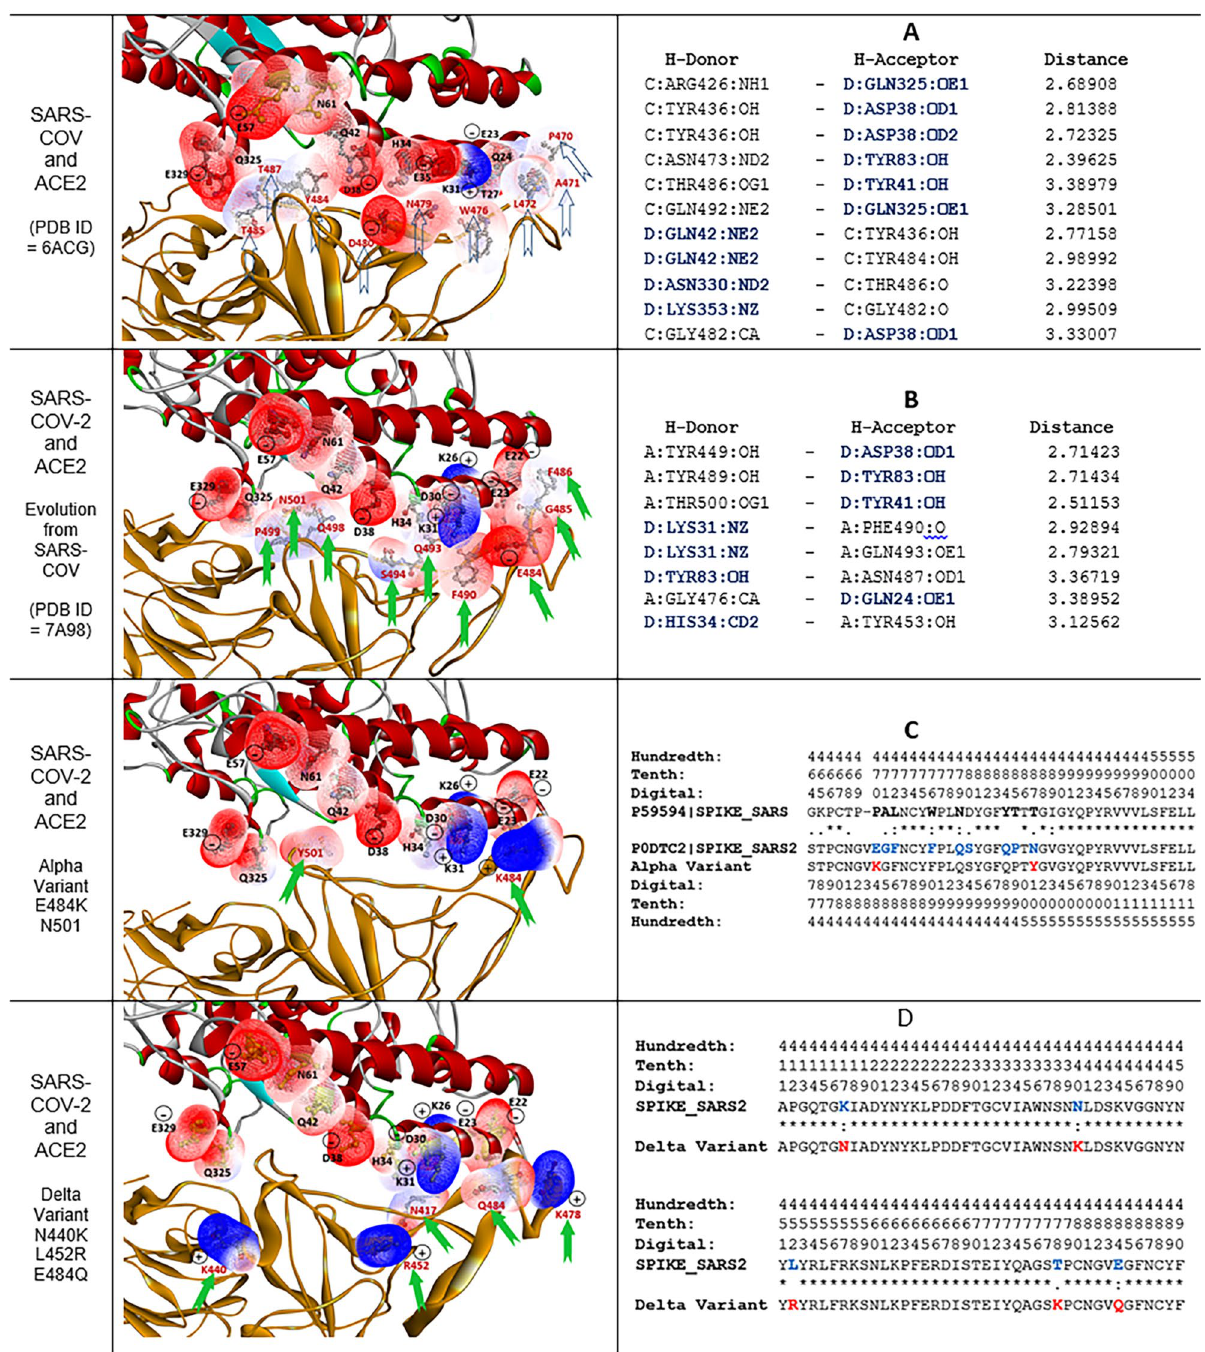
Figure 3. Coronavirus evolution enhanced the interaction of the spike protein with ACE2. The 3D images display the binding interface between RBD of the SARS-CoV-2 spike protein and ACE2. The protein structure shown in brown color is SARS-CoV or SARS-CoV-2. The wire meshes represent the charge surfaces for residues involved in the interaction; red wire mesh indicates negative charge, and blue indicates positive charge. Row A shows the SARS-CoV structure and intermolecular H-bonds (PDB ID 6ACG); row B shows SARS-CoV-2 and H-bonds (PDB ID 7A98). Row C shows the structure of the Alpha variant, and row D shows the structure of the Delta variant, which were both obtained by computational modeling. The contributions of hydrogen bonds from ACE2 are marked by blue bold font. The arrows indicate the residues altered in viral evolution. The sequences of SARS-CoV (UniProtKB = P59594 (SPIKE_SARS)), SARS-CoV-2 (UniProtKB = P0DTC2 (SPIKE_SARS2)) and the Alpha variant and Delta variant are aligned and listed in row C and D , and the mutational residues are shown in colored bold